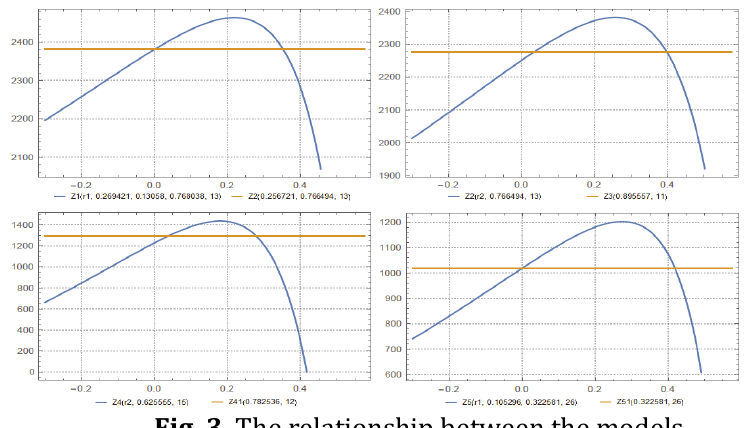
Fig. 3. The relationship between the